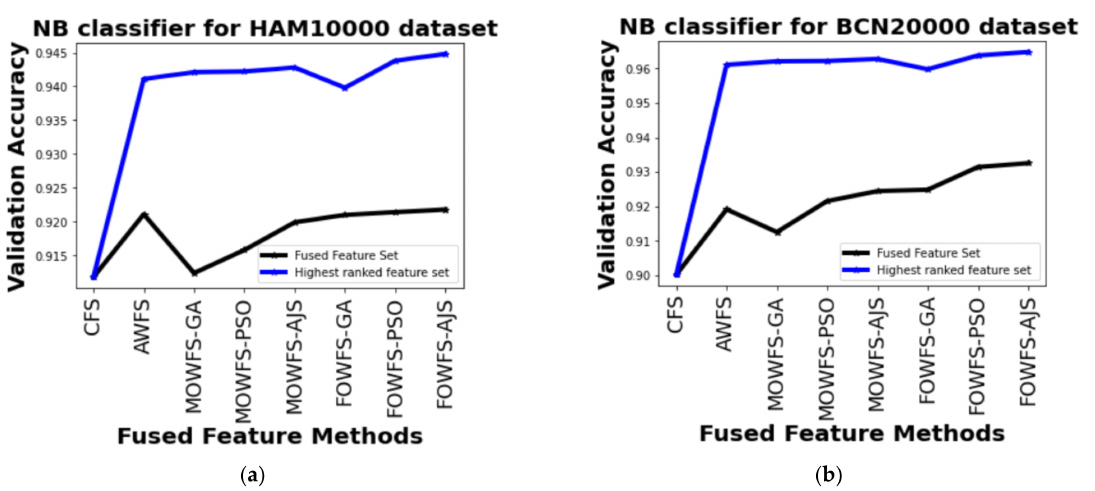
Figure 7. Comparison of validation accuracy for fused feature set and highest ranked feature